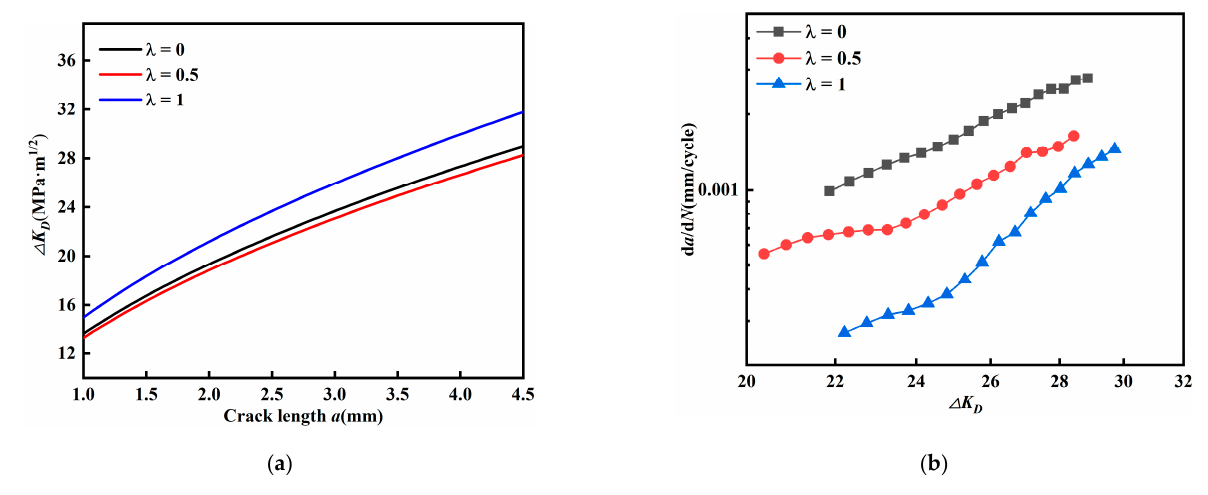
Figure 14. Demir model. ( a ) Relationship between a and △ K D ( β = 60°). ( b ) Relationship between a and △ K D ( β = 60°).